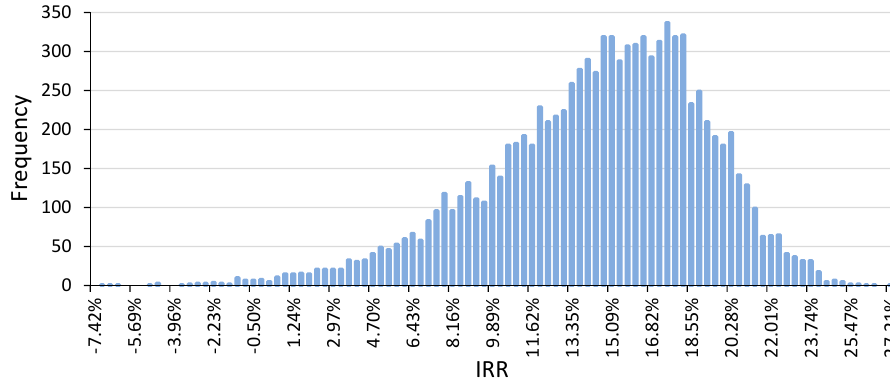
Figure 18. Histogram of the IRR calculated with the Monte Carlo method for a 500 kW system.